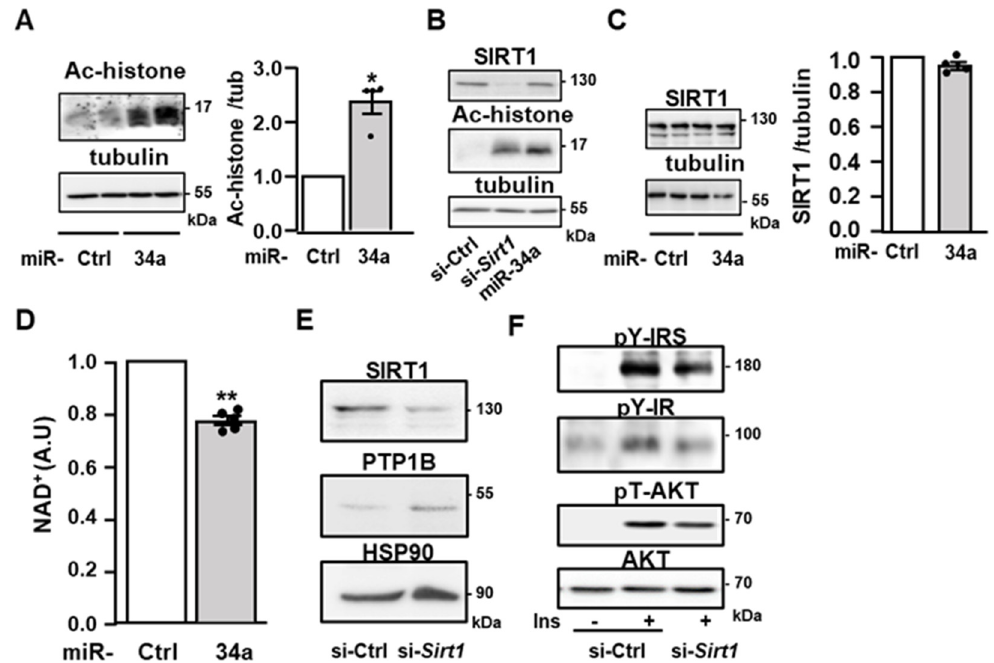
Figure 6. miR-34a increases histone acetylation and decreases NAD + level: ( A ) Representative immunoblot ( left panel) of the level of acetylated histones (Ac-histone) detected with a pan-acetyl lysine antibody in 3T3-L1 adipocytes transfected with a control miRNA (miR-Ctrl) or a miR-34a mimic. Tubulin was used as loading control. Bar graph ( right panel) represents the densitometry analysis for the acetylated histones/tubulin ratio. Data are mean values ± SEM of four independent experiments. * p < 0.05. ( B ) Representative immunoblot of the expression of SIRT1, acetylated histones detected with an antibody against pan-acetyl lysine, and HSP90 as loading control in 3T3-L1 adipocytes transfected with a siRNA against Sirtuin-1 ( Sirt1 ) or a control siRNA (si-Ctrl), or with a miR-34a mimic. A representative immunoblot of two independent experiments is shown. ( C ) Representative immunoblot ( left panel) of the expression of SIRT1 with tubulin as loading control in 3T3-L1 adipocytes transfected as in ( A ). Bar graph ( right panel) represents the densitometry analysis for the SIRT1/tubulin ratio. Data are mean values ± SEM of four independent experiments. ( D ) NAD + level in 3T3-L1 adipocytes expressed relative to the cells transfected with control miRNA. Data are mean values ± SEM of four independent experiments. ** p < 0.01. ( E ) Representative immunoblot of the expression of SIRT1, PTP1B and HSP90 (loading control) in 3T3-L1 adipocytes transfected with a control siRNA (si-Ctrl) or a siRNA against Sirt1 . ( F ) Representative immunoblot of the level of the tyrosine phosphorylation (pY) of IR and IRS, phosphorylation of AKT on threonine 308 (pT-AKT), and expression of AKT in 3T3-L1 adipocytes transfected as in ( E ) and treated without or with insulin (Ins, 0.5 nM) for 10 min.